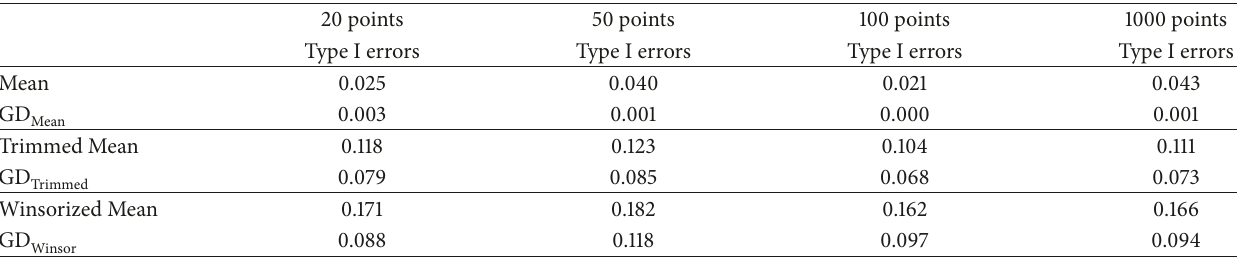
Table 52: Contaminated 𝜒 2 distributions with 50% noise level.